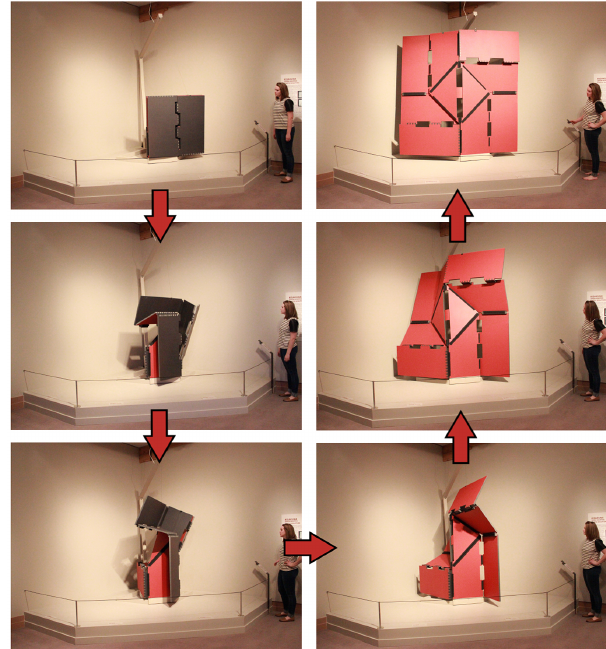
Figure 3. The unfolding of an origami-based kinetic sculpture which employs the OPT. The mechanism is made of panels with a thickness of one inch. This was part of an exhibit in BYU’s Mu- seum of